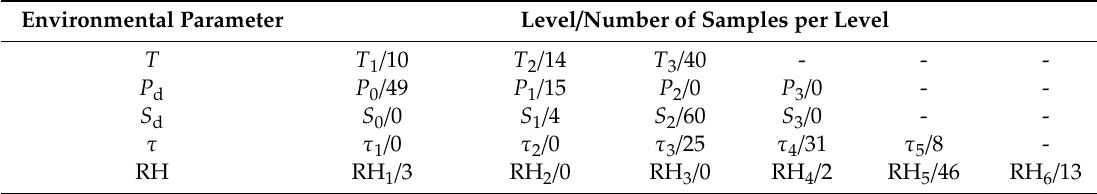
Table 2. Environmental parameters and levels employed in the ANOVA analysis.